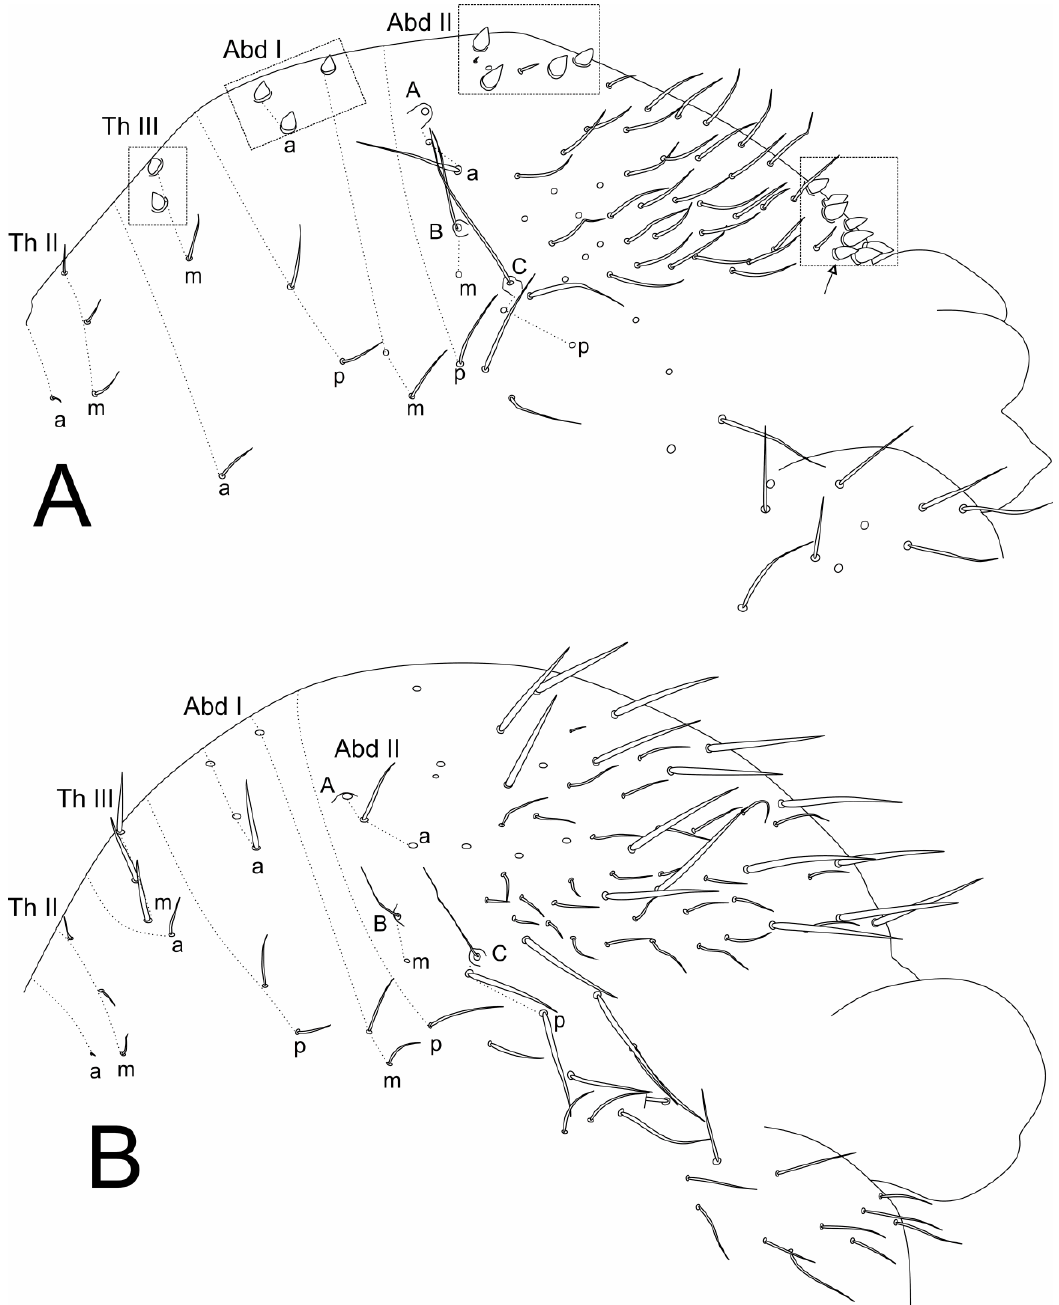
Figure 3. Richardsitas subferoleum sp. nov. large abdomen: ( A ) male, squares highlight fields of short candle-shaped chaetae on dorsum; ( B ) female.